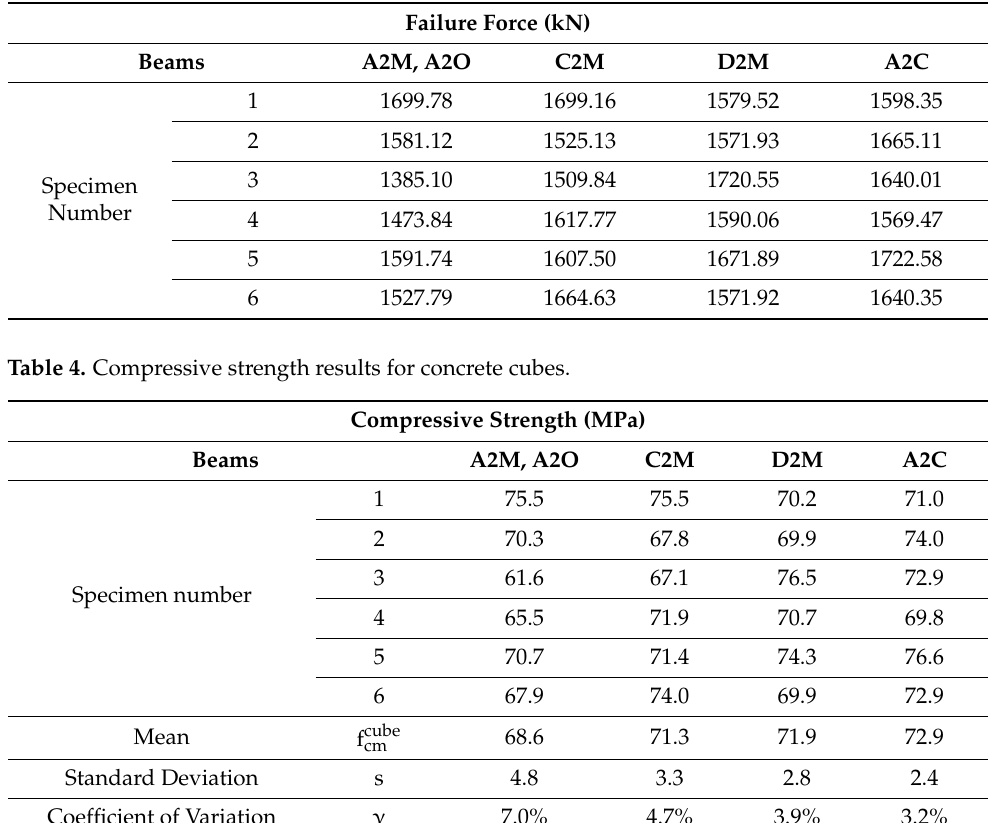
Table 3. Summary of failure forces for concrete cubes.